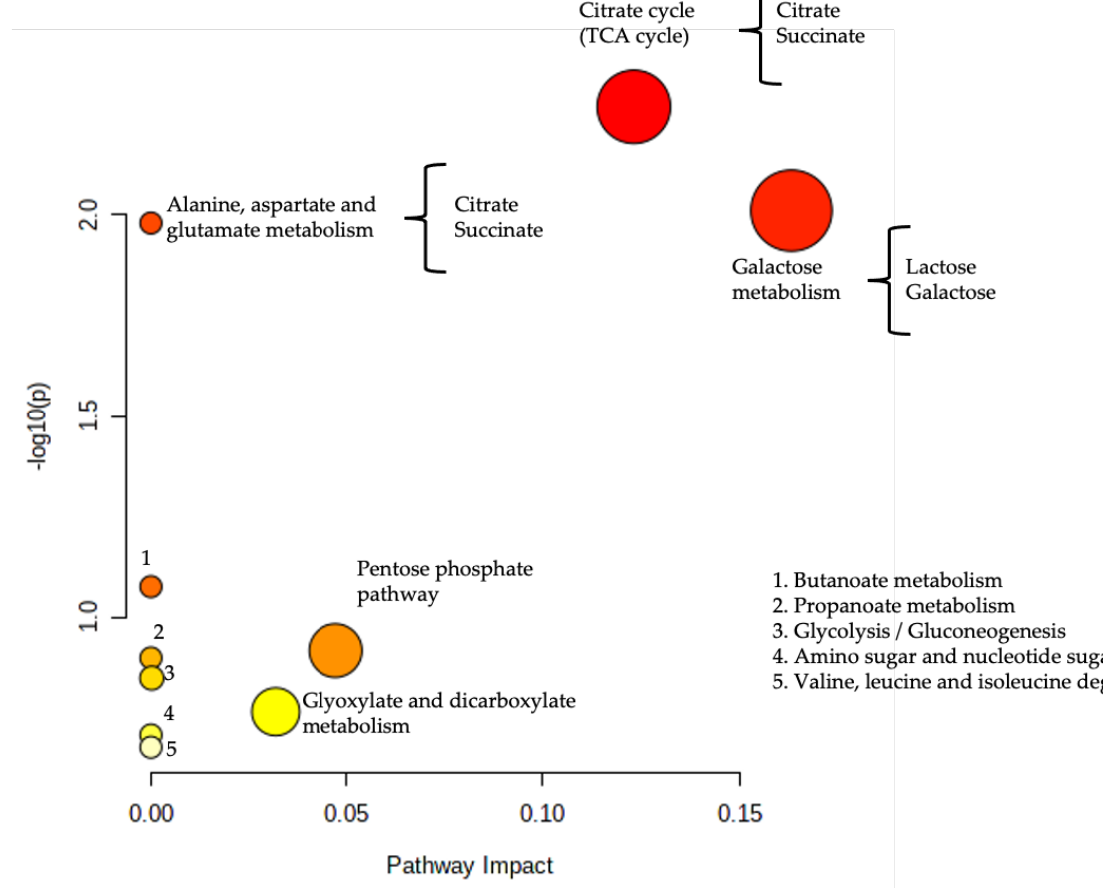
Figure 5. Metabolic pathway alterations observed in the studied preterm newborns. The x-axis represents the topology analysis (pathway impact), and the y-axis represents the enrichment analysis ( − log( p )). The color and size of each pathway were set according to the p values and pathway impact values, respectively.